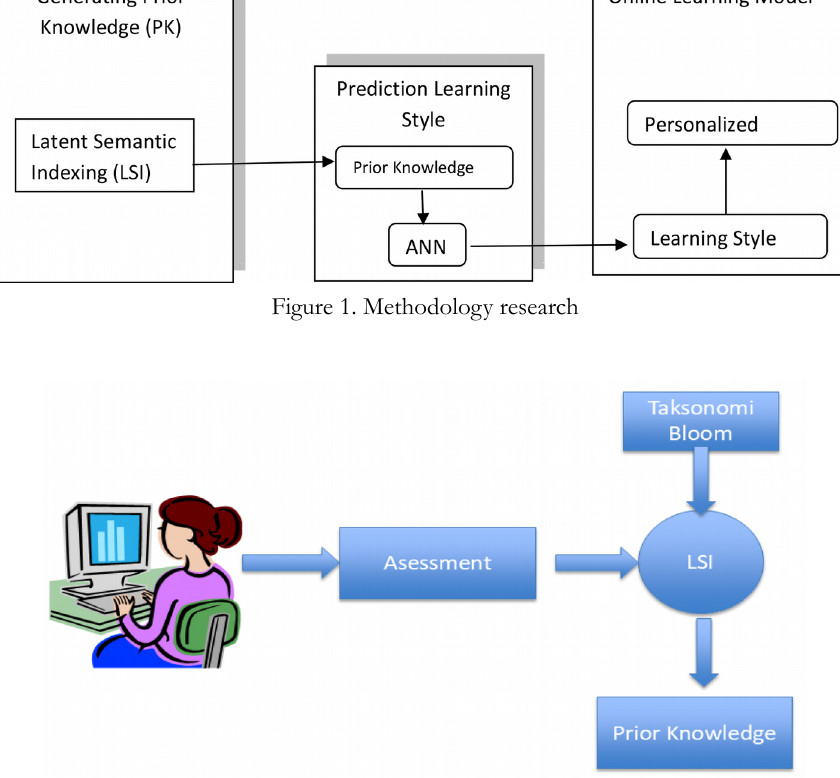
Figure 2. Prior knowledge architecture (Hasibuan & Nugroho,